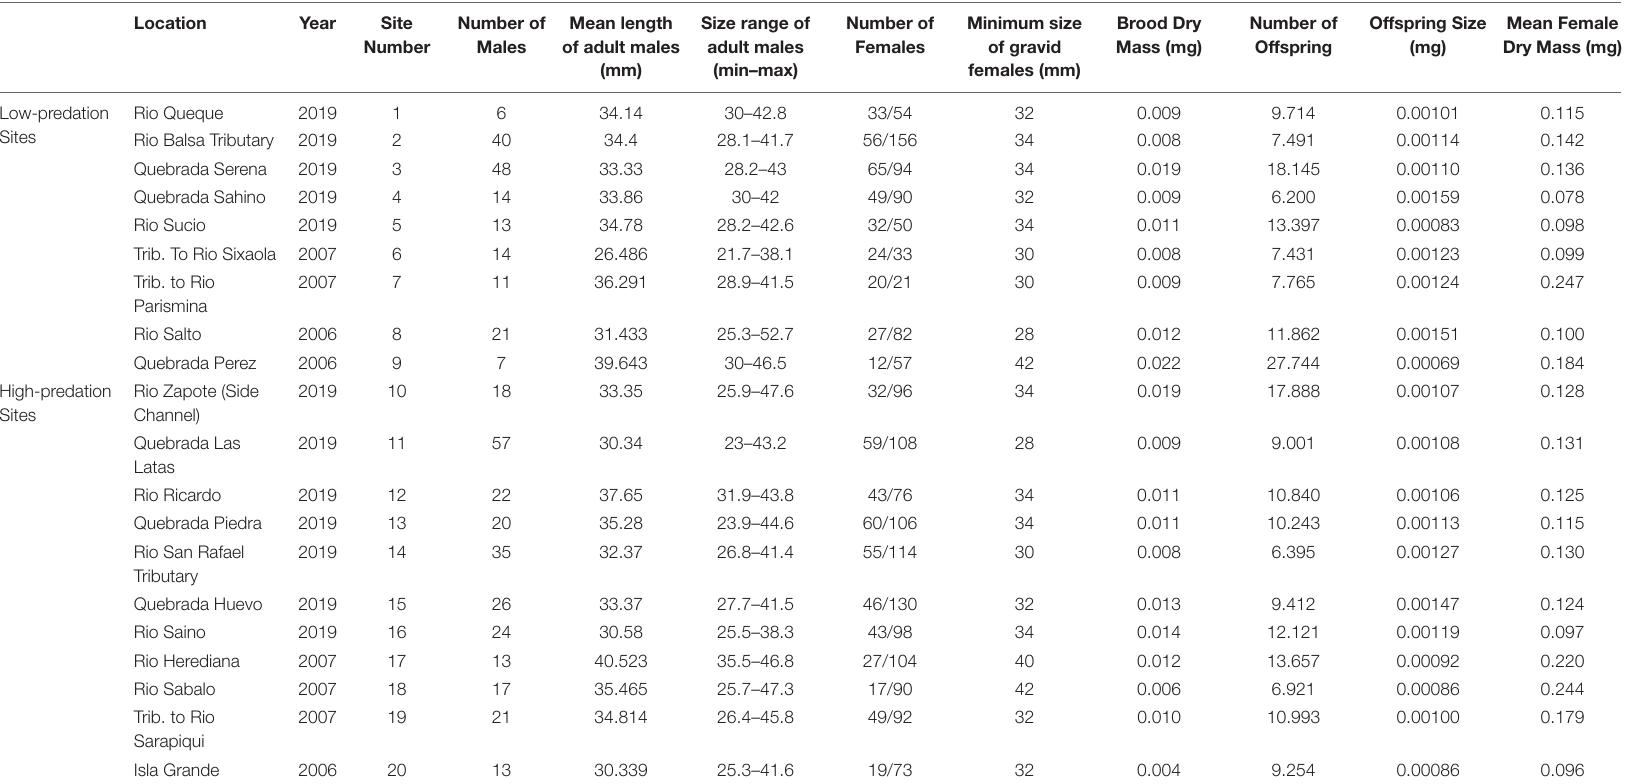
TABLE 1 | Descriptive statistics for life history characteristics of Alfaro cultratus for 20 populations.